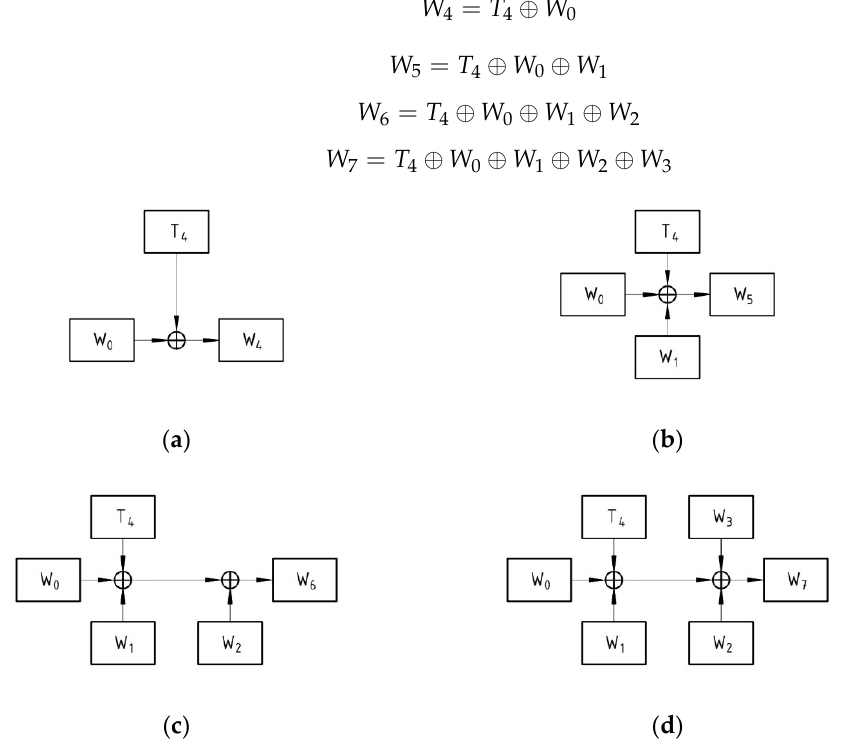
Figure 4. Subkeys generation, ( a ) W4, ( b ) W5, ( c ) W6, and ( d )